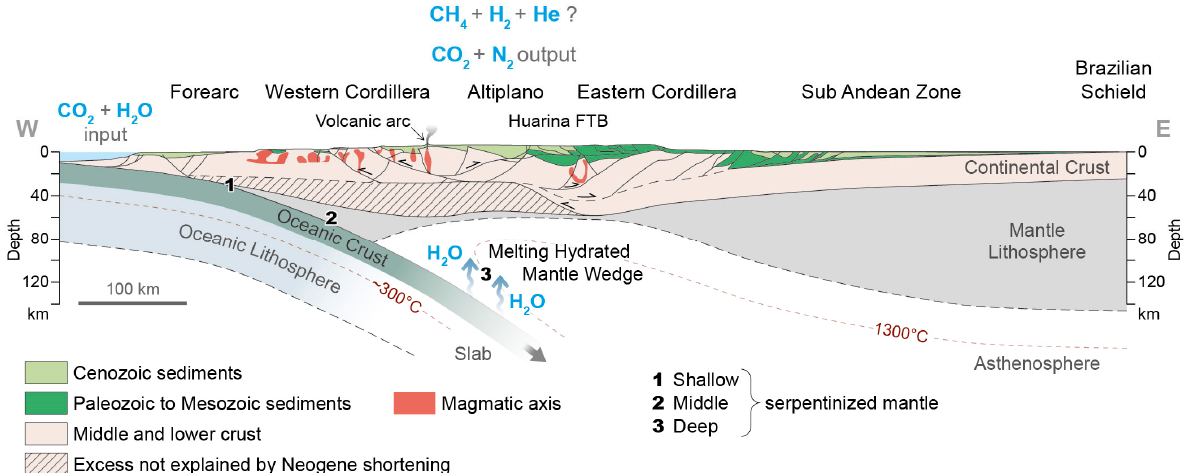
Figure 2. Schematic view of the Paci fi c subduction below the Andes at about 20° S and of its gas and water budget. Water, CO 2 , and N 2 , among others, are pushed down with the sediments covering the subducting oceanic crust. Part of this water is incorporated within the serpentine that forms during the burial of this oceanic lithosphere ( 1 ). At a deeper level, the mantle lithosphere of the overriding plate is also hydrated ( 2 ). The serpentinites remain stable for a while, but when the temperatures surpass 1000 °C, the water is released and hydrates the hot asthenospheric mantle wedge that melts ( 3 ). In this cross-section, the overriding plate corresponds to the Andes in Bolivia (modi fi ed from [32,33]).